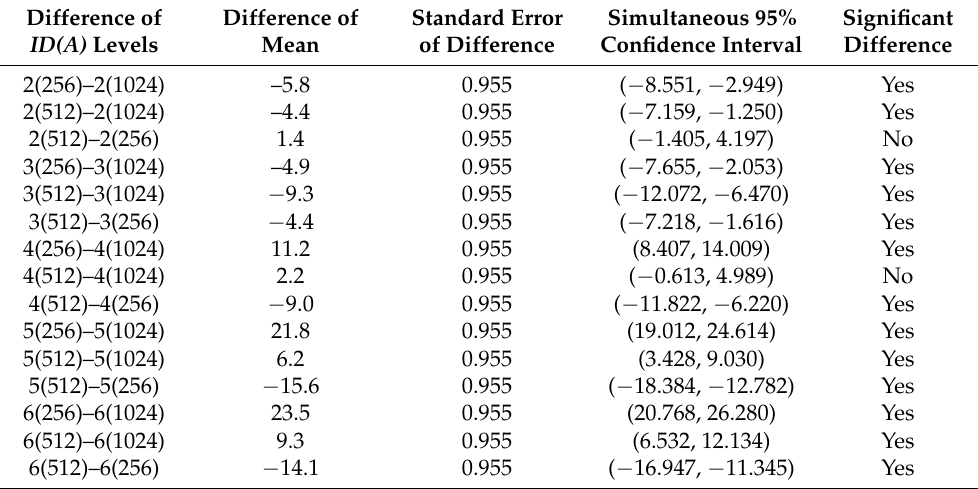
Table 7. Dunn–Šid á k simultaneous test for the planned contrasts (individual confidence level = 99.66%), indicating that most tasks with the same ID do not have identical perceived